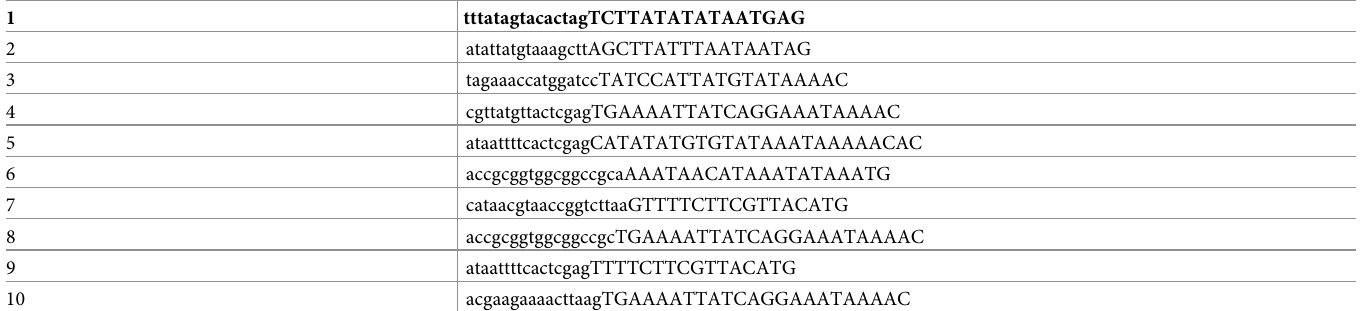
Table 2. Primers used for cloning. Nucleotides in lowercase show the overhangs introduced into oligonucleotides that are necessary to use InFusion